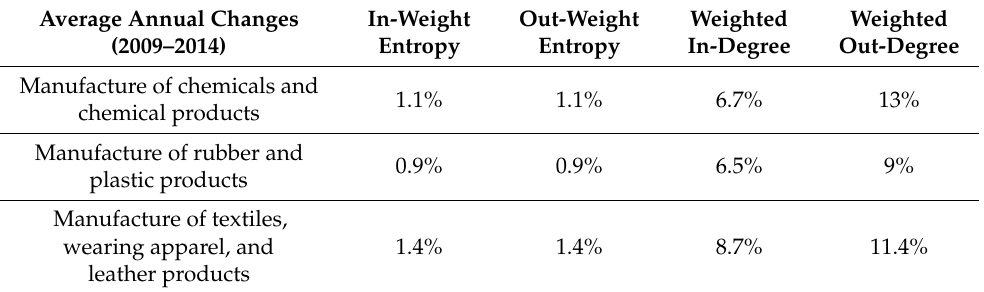
Table 1. Average annual changes (2009–2014) for weight entropies and weighted